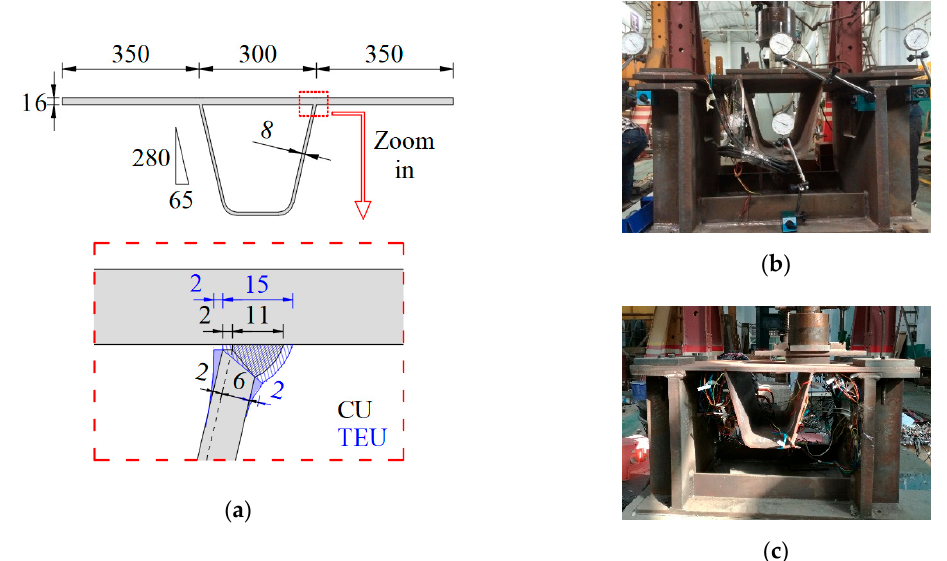
Figure 1. Fatigue test of rib-to-deck specimens: ( a ) Sectional view (Unit: mm); ( b ) Test set-up of central loading; ( c ) Test set-up of eccentric loading.